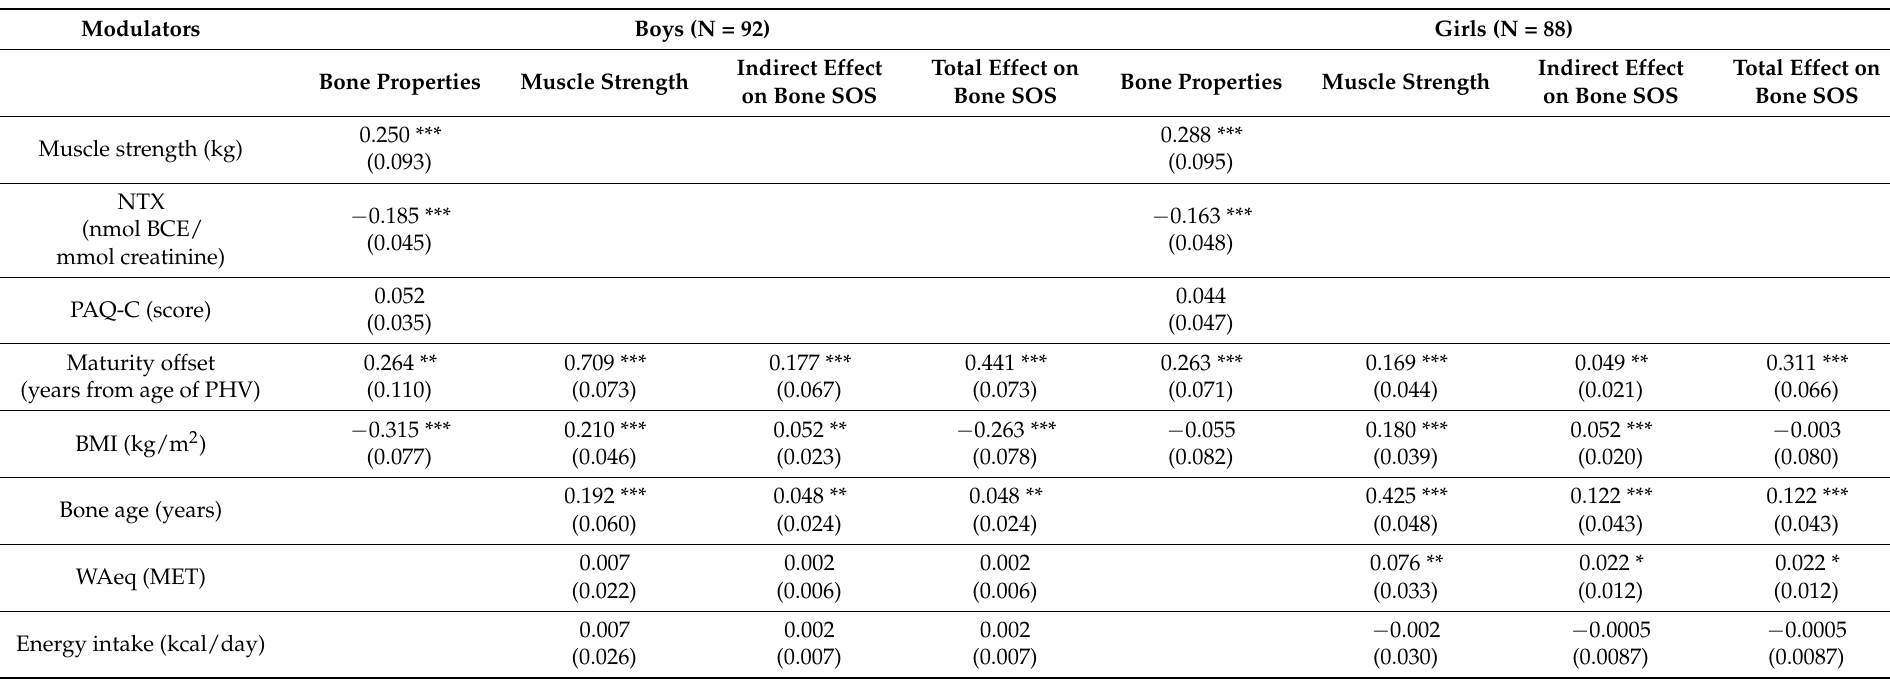
Table 3. Functional model of bone development results for boys and girls, separately. Values are β -coefficients with standard errors in